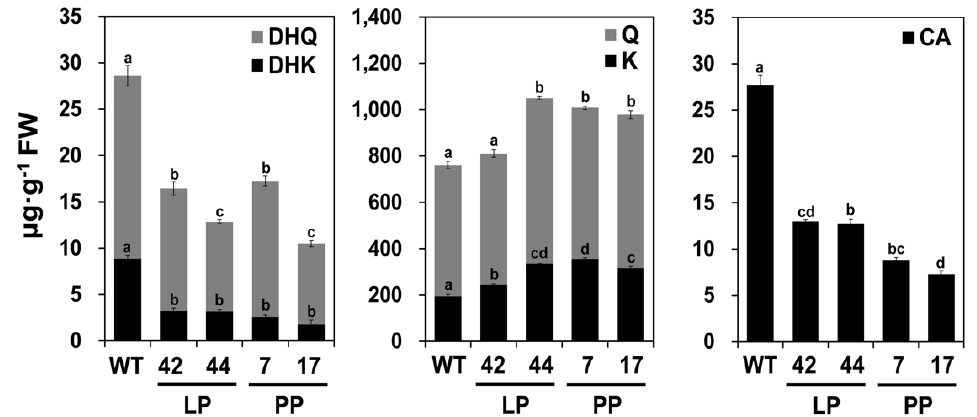
Figure 4. Flavonoid contents in the petals of transgenic tobacco flowers expressing AcFLS-HRB. A, HPLC analysis of flavonoid aglycones extracted from the petals of WT and transgenic lines (42, 44, 7, 17) via acid hydrolysis. Peaks corresponding to dihydroflavonols (DHQ and DHK), flavonols (Q, quercetin; K, kaempferol), and cyanidin (CA) were detected at 288 nm, 350 nm, and 520 nm, respectively. B, Flavonoid contents were measured in accordance with the area of each standard. Error bars indicate ± SD from three replicates. Statistical significance was determined by one-way ANOVA with post-hoc Tukey’s tests. Significant differences between means ( p < 0.05) are indicated by lower-case letters (a, b, c, and d) above the bars. LP, light pink transgenic lines; PP, pale pink transgenic lines.